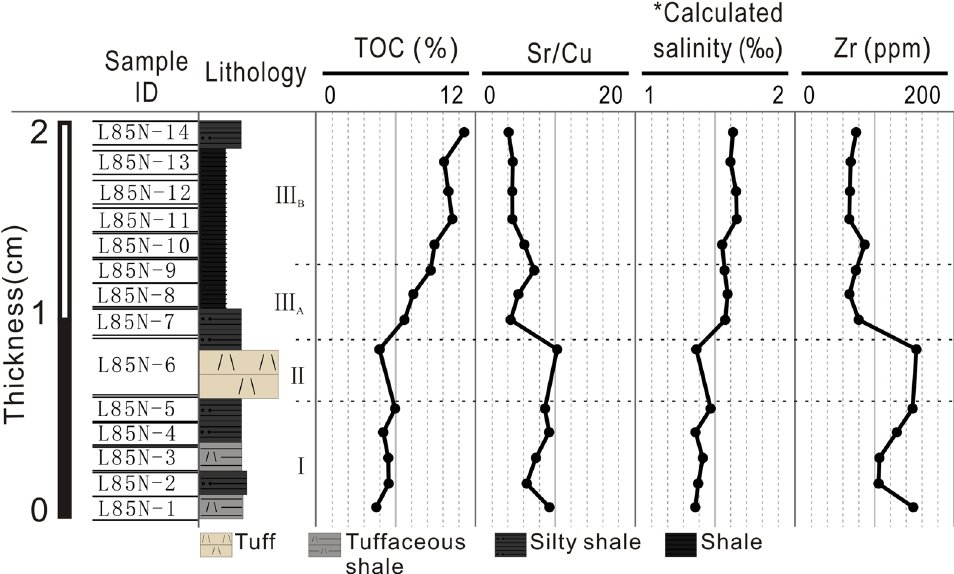
Figure 7. Zr element, calculated salinity, and Sr/Cu profiles for 14 samples, which could be used to indicate the palaeowater depth, paleosalinity, and paleotemperature, respectively. *The salinity was calculated based on equivalent boron content following the formula proposed by Couch 54